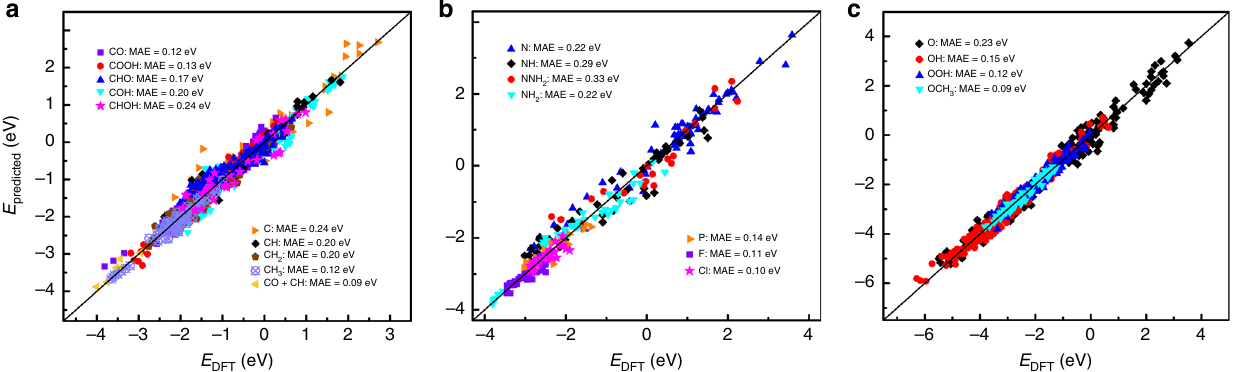
Fig. 7 Comparison between the predicted adsorption energies and the DFT-calculated results. In each case, the constant θ is obtained by using Au data for species binding via C and Cu data for species binding via N and O on transition metals (TMs) and nanoparticles (NPs) (for the few literatures without Au and Cu using the calculated metals), by using Co-doping data (if unavailable using Rh-doping data) on near-surface alloys (NSAs), and by using V-based data (if unavailable using Ir-based data) on oxides. a , b , and c show the results for species binding via C 11,15,18,24 – 28,30,39,44,45,47,48,51 – 55 ( a ), species binding via N 16,27,30,47 ( b ) (the relatively large scatter compared with other species mainly due to the change of adsorption sites and adsorption con fi gurations from one surface to the next 16 ), and species binding via O 10,11,19,20,22,23,30,32,35,37,38,40 – 43,49 ( c ). Color code for the type of adsorbates is provided as insets together with mean absolute errors (MAEs). The low MAEs comparable to the approximate error (±0.2 eV) of DFT calculations with (semi-) local functionals, the generality of the studied adsorbates and substrates, and the large amount of available data (2055 different adsorption energies) consistently support the applicability of our scheme and corroborate the proposed physical picture for adsorption as discussed in the text. Therefore, this scheme can be used to predict or estimate the adsorption properties of multifaceted TMs, NSAs, and oxides, with reasonable accuracy. Source data are provided as a Source Data fi the N oe of metal B is an indicator of its binding ability with oxygen, whereas p -band-SO likely re fl ects the electronic structure perturbation of oxide surfaces induced by adsorption. These results indicate that ψ is linked with the outer-electron char- acteristics of surface atoms for oxides.